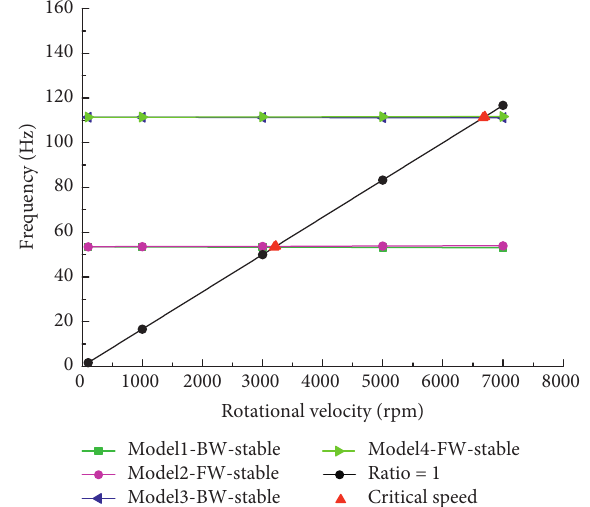
Figure 4: Campbell diagram of our flexible shafting system